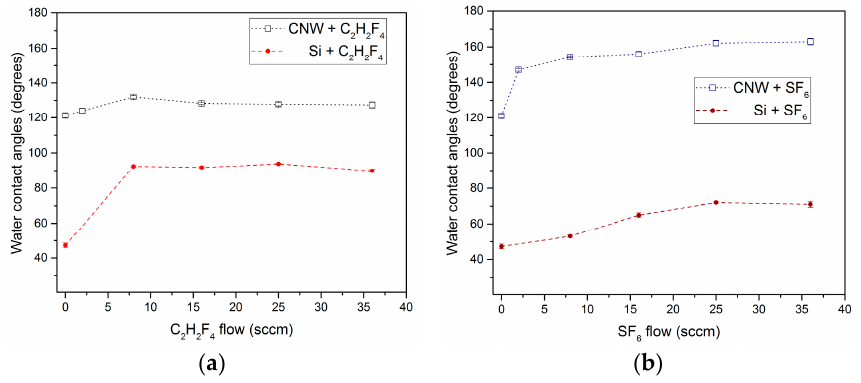
Figure 14. Contact angles of CNW layers and Si wafer after plasma exposure to ( a ) C 2 H 2 F 4 PACVD process; and ( b ) SF 6 plasma treatment.